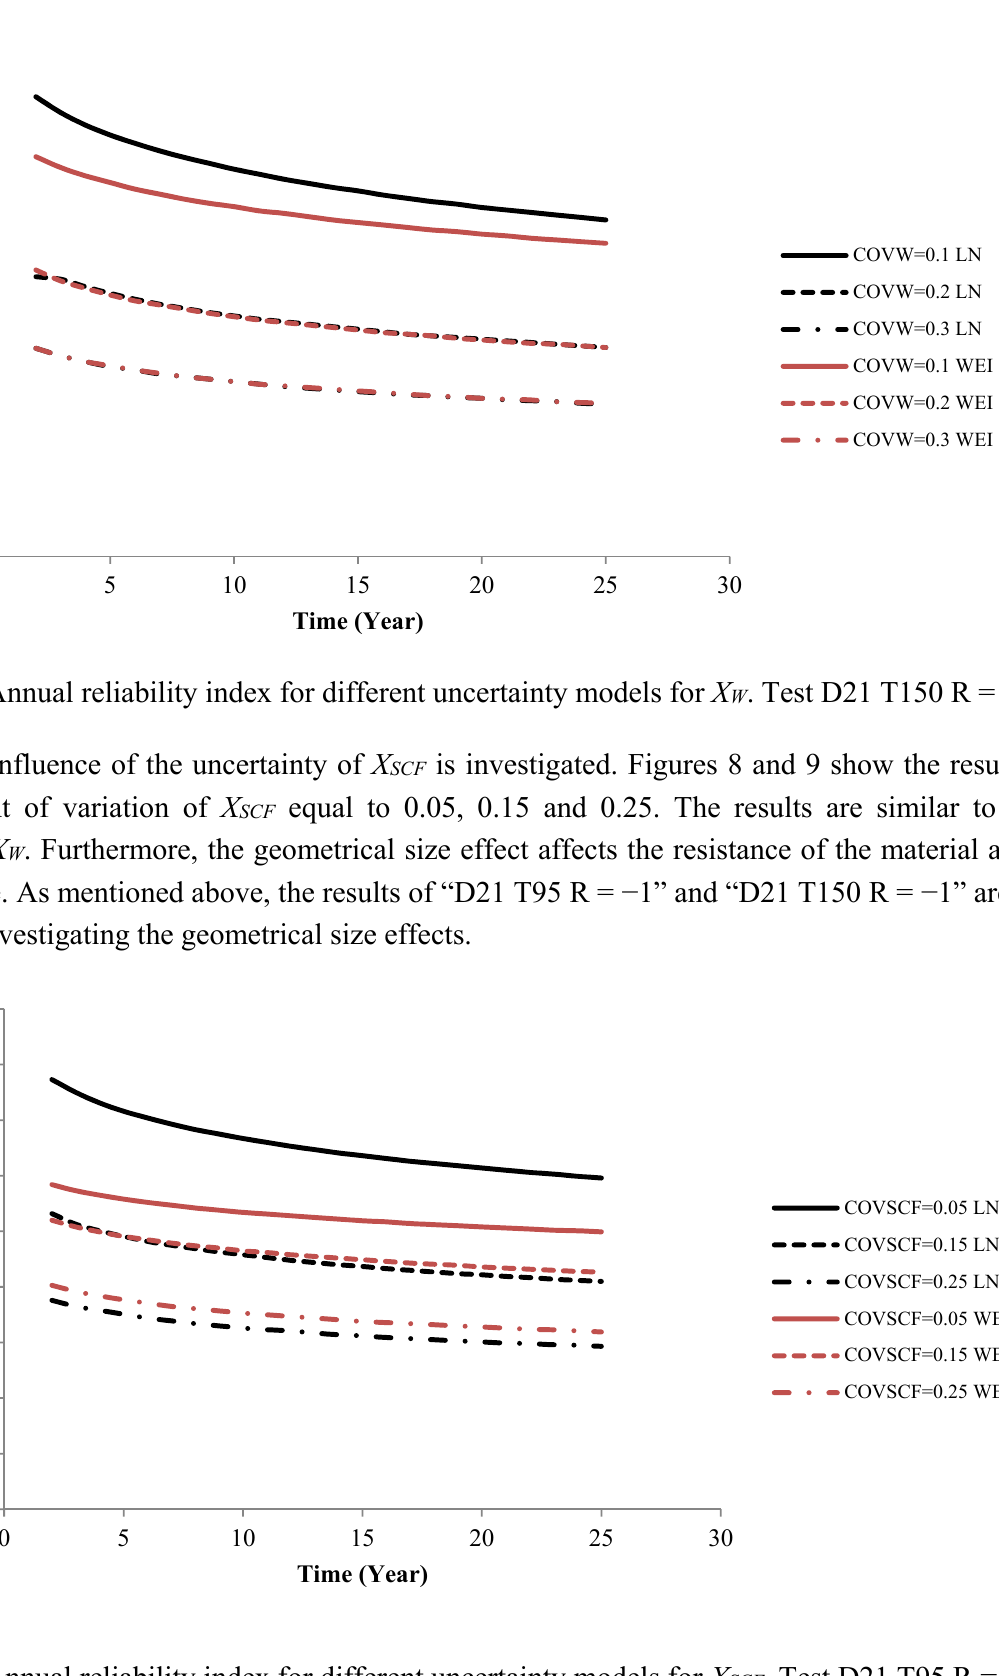
Figure 8. Annual reliability index for different uncertainty models for X SCF . Test D21 T95 R = −